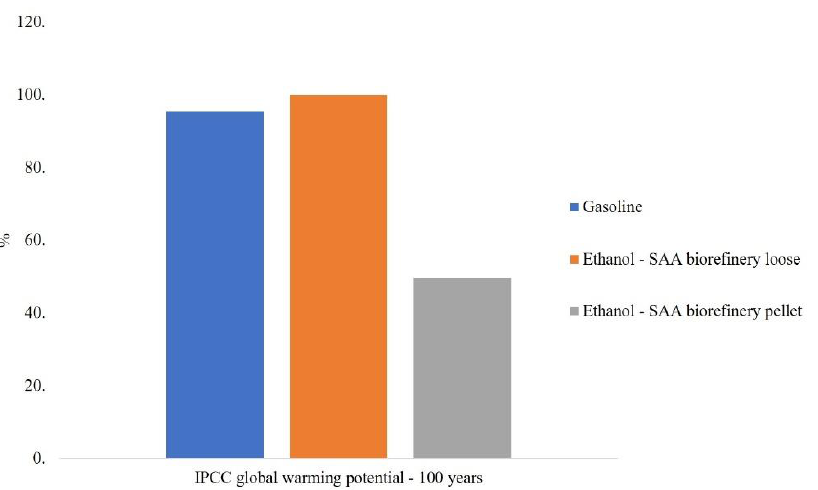
Figure 6. Comparison of the global warming impact of 1 Megajoule (MJ) gasoline, 1 MJ ethanol using loose and pelleted biomass.